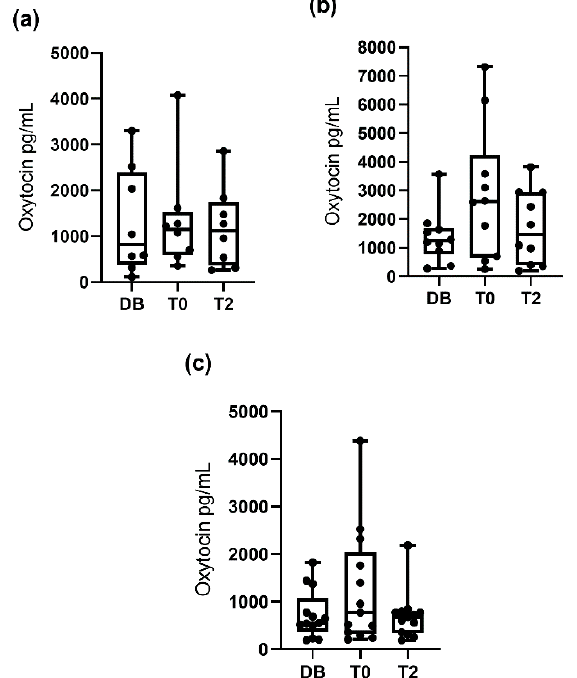
Figure 2. Changes in salivary oxytocin concentrations measured with AlphaLISA monoclonal assay at different times: the day before ejaculate collection (DB), immediately after starting the ejaculation (T0) and two hours after ejaculation (T2). Figure ( a ) shows the data for boars aged 12–24 months and ( b , c ) those for boars aged 24–36 and aged more than 36 months, respectively. The plots show medians (line within box), 25th and 75th percentiles (boxes), min and max values (whiskers) and individual data points.